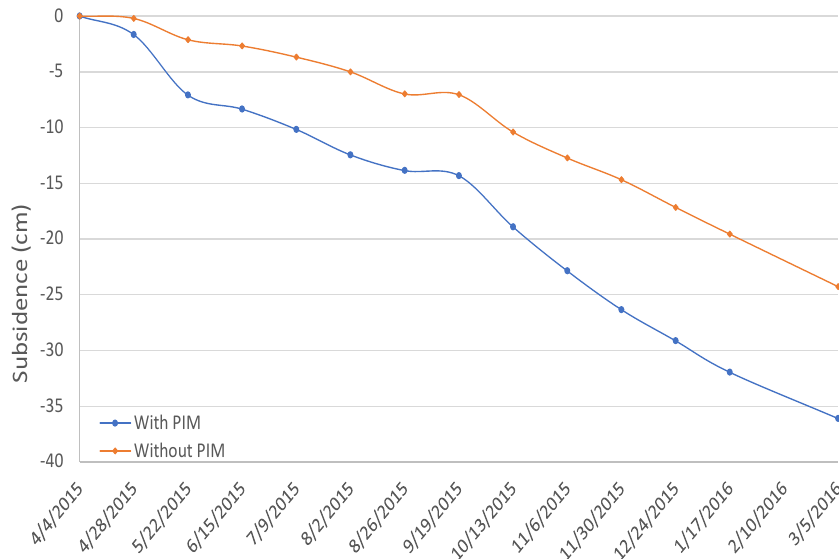
Figure 6. The time-series subsidence in the Line-of-Sight (LOS) direction at the location with the maximum subsidence value.